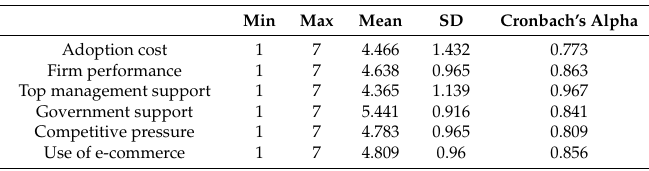
Table 6. Descriptive statistics and Cronbach’s alpha.